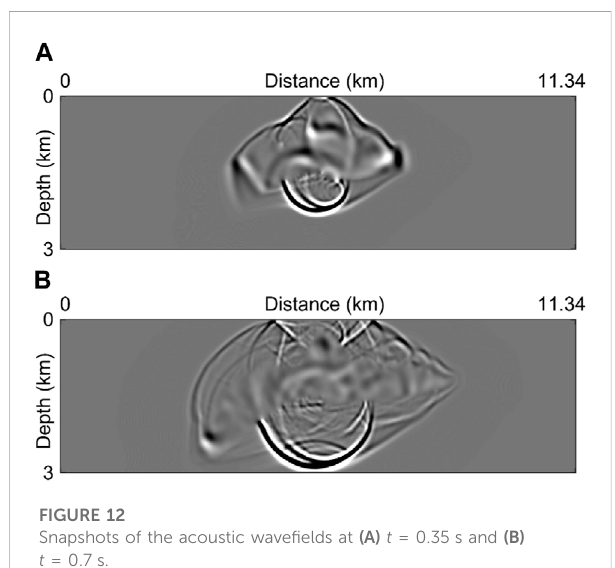
FIGURE 12 Snapshots of the acoustic wave fi elds at (A) t = 0.35 s and (B) t = 0.7